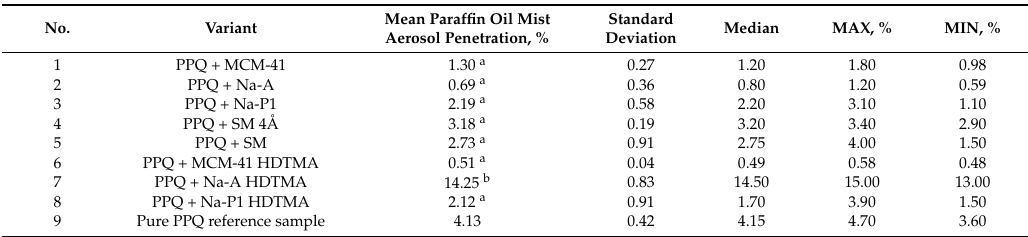
Table 5. Mean paraffin oil mist aerosol penetration for nonwoven composites containing zeolite and silica materials (descriptive statistics).